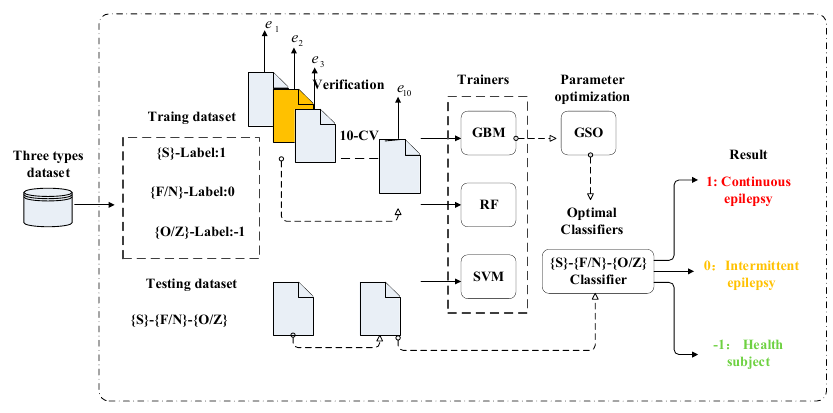
Figure 4. Classification implementation.